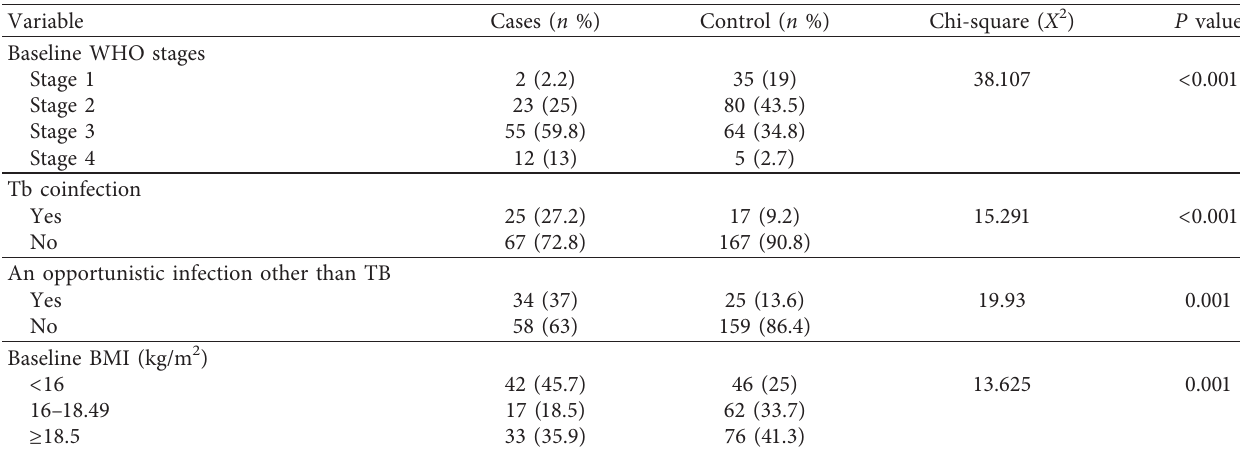
Table 4: Clinical-related factors on ART clients at Waghimra zone health institution ART clinic, Northern Ethiopia, in 2019 ( n � 276 ) .